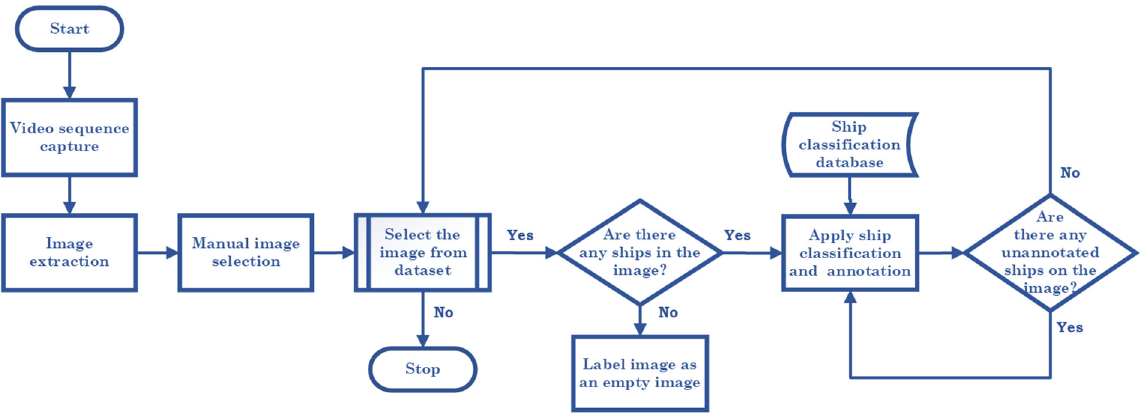
Figure 1. Dataset creation flowchart.